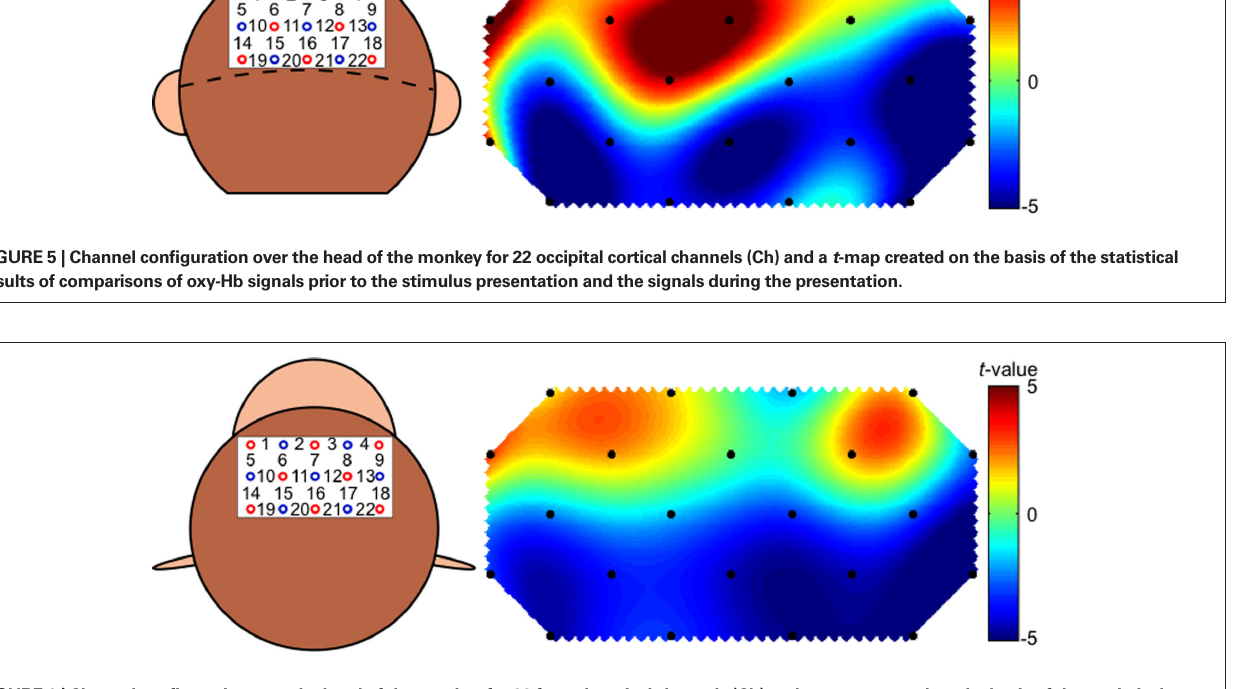
Figure 6 | Channel configuration over the head of the monkey for 22 frontal cortical channels (Ch) and a t -map created on the basis of the statistical results of comparisons of oxy-Hb signals prior to the stimulus presentation and the signals during the